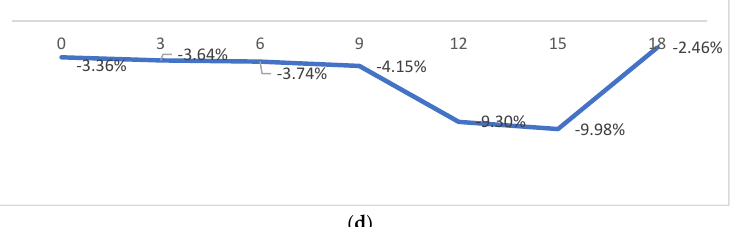
Figure 4. Viscous analysis. ( a ) Skin friction contour of NACA 0012. ( b ) Skin friction contour of 1RR HPBA. ( c ) Viscous generated at all angles of attack. ( d ) Viscous drag in percentage.